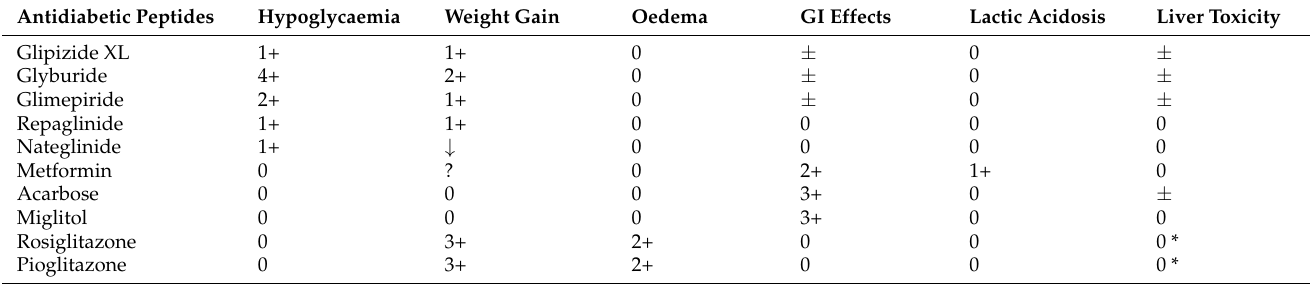
Table 3. Antidiabetic peptides for type 2 diabetes mellitus (T2DM).